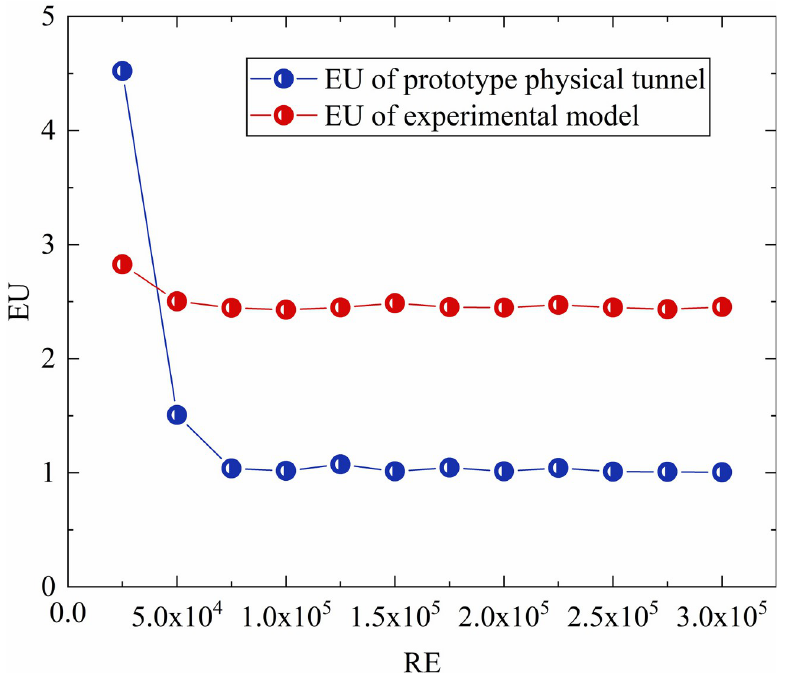
Fig 4. Comparison of EU vs. RE trends for real and experimental models.